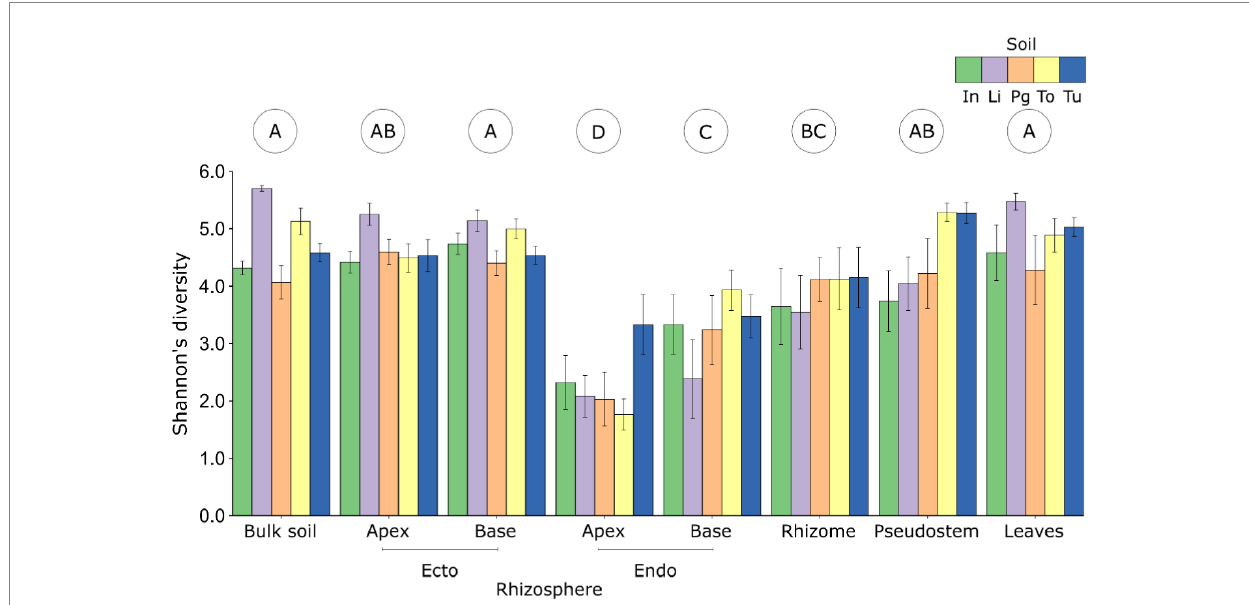
FIGURE 1 The alpha diversity (numbers of observed OTUs) of fungal communities associated with different plant compartments of Musa (AAA Group, Cavendish Subgroup) ‘Williams’ grown in pots with five distinct soils. Error bars represent standard errors of the means. Letters in circles indicate compartments that differ according to Tukey post hoc tests. endo, endorhizosphere; ecto, ectorhizosphere; In, Innisfail; Li, Liverpool; Pg, Pin Gin; To, Tolga; Tu, Tully.